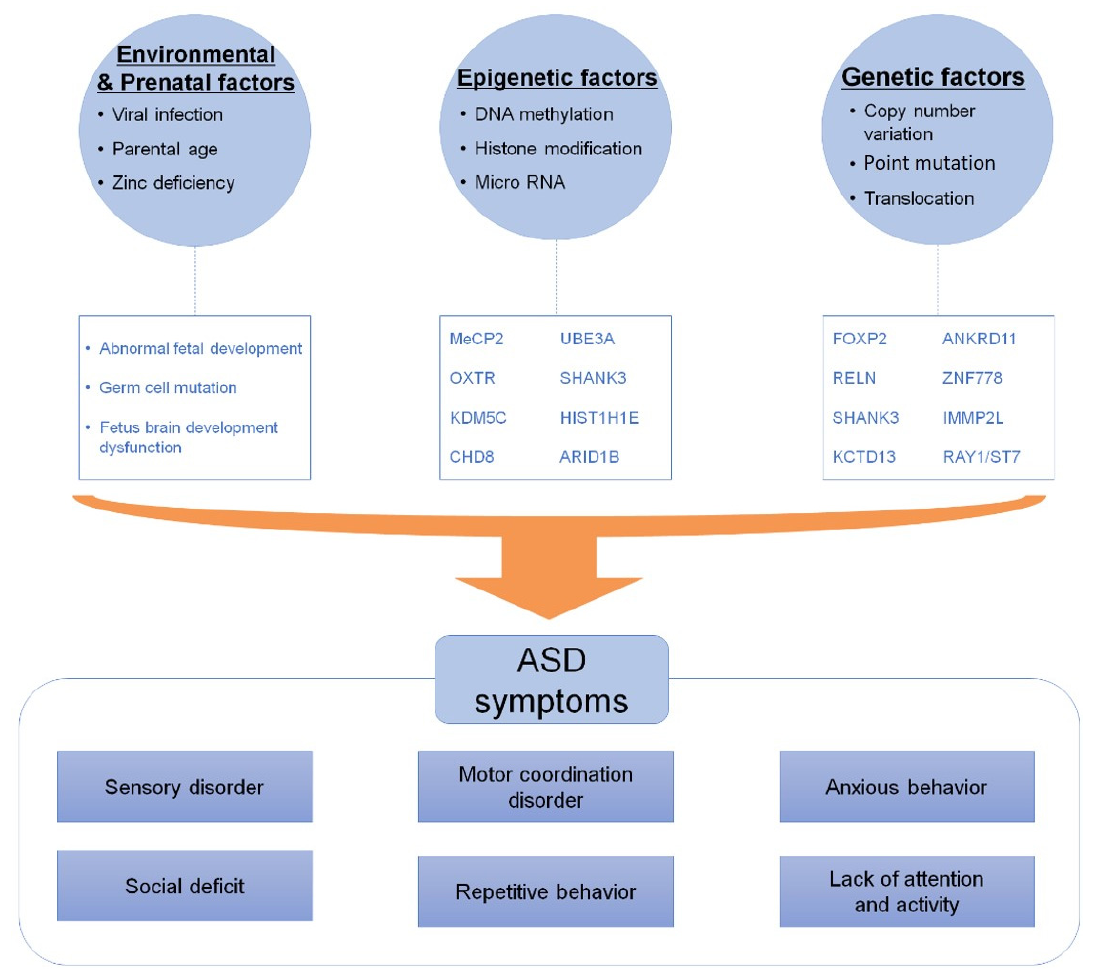
Figure 1. Comprehensive overview of the diverse etiology of autism spectrum disorder (ASD). Although definitiveetiologyandpathogenesisunderlyingASDhavenotyetbeenidentified, accumulatedevidence has identified various risk factors, including environmental, genetic, and epigenetic